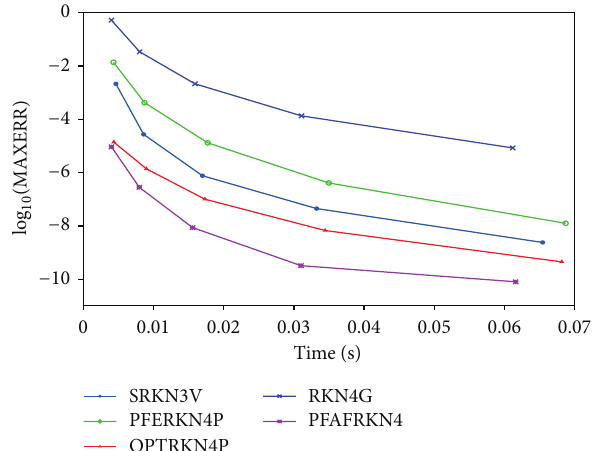
Figure 10: Efficiency curves for all methods for Problem 1 with 𝑒 = 0.1 and ℎ = 1/2 𝑖 , 𝑖 = 3, ...,7 .